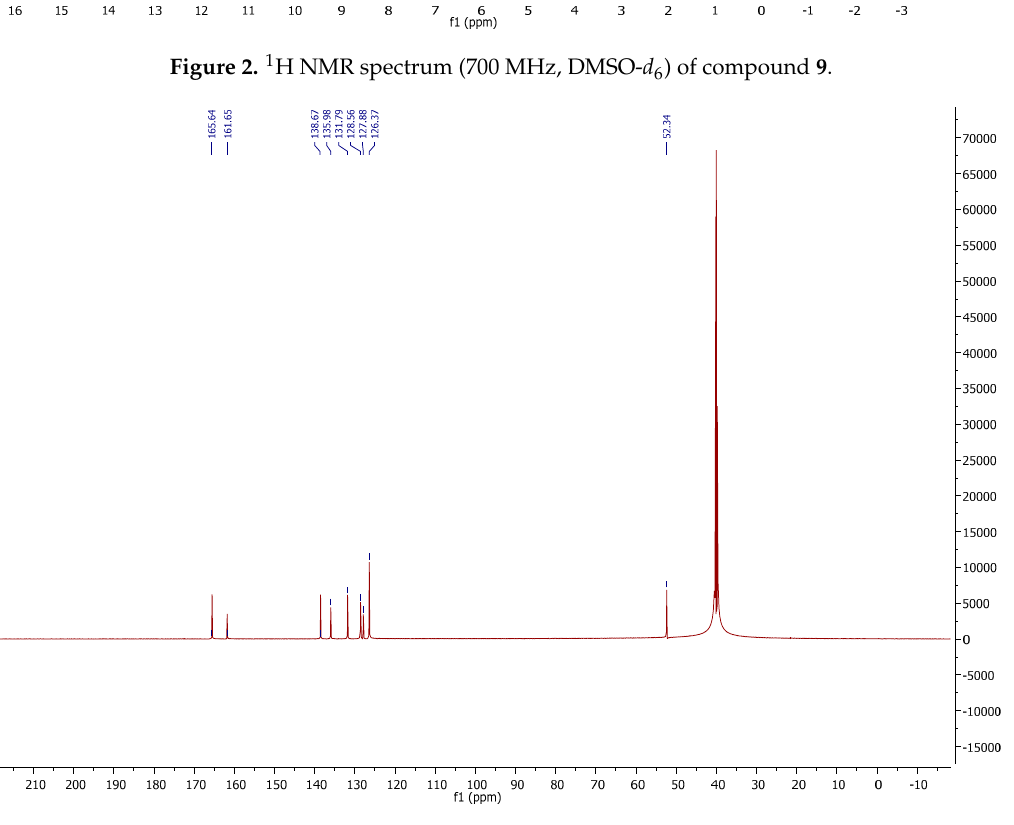
6 ) of compound 9 .